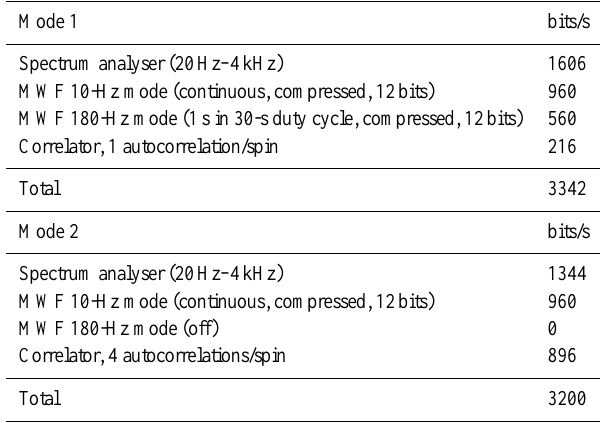
Table 1. The two main modes of operation of DSP-TC1 STAFF- DWP